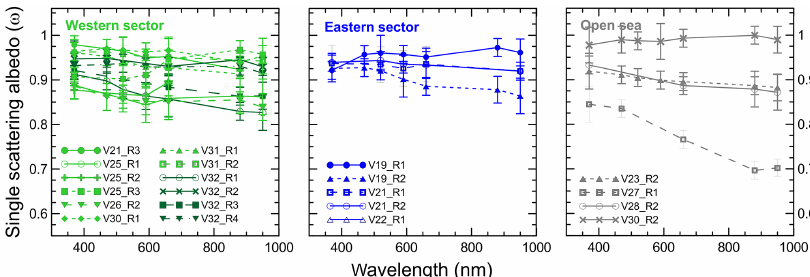
Figure 5. Spectral single scattering albedo at seven wavelengths between 370 and 950nm calculated from nephelometer and aethalometer measurements for the different SLRs within pollution layers. Data are separated based on the different air mass origin (Western sector, Eastern sector, and Open sea).